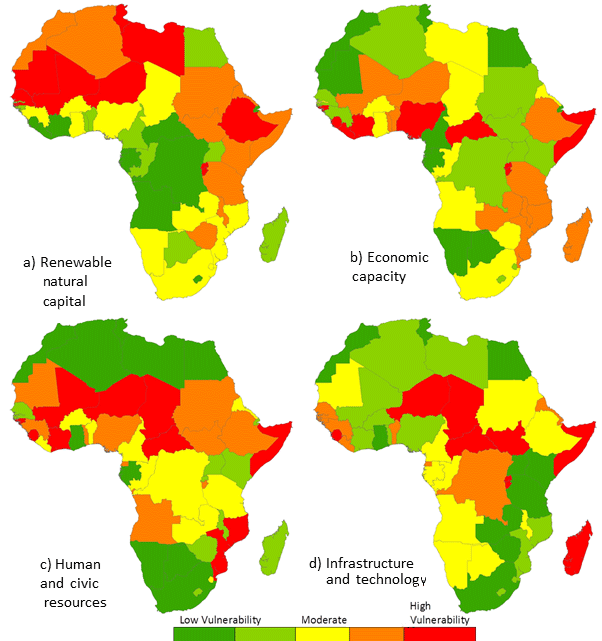
Fig. 9. Four components of the drought vulnerability index (DVI); (a) Renewable Natural Capital, (b) Economic Capacity, (c) Human and Civic Resources and (d) Infrastructure and Technology. The dif- ferent levels of vulnerability were classified by dividing the sample in quintiles. Table 3. Contingency tables and tetrachoric coefficient ( r t ) for the number of persons reported affected (PRA) by drought disasters and DVI. The analysis was performed over the 47 African coun- tries with disaster data. Source: EM-DAT: the OFDA/CRED Inter- national Disaster Database – www.emdat.be, Université Catholique de Louvain, Brussels (Belgium). High DVI Low no. persons reported affected High no. persons reported